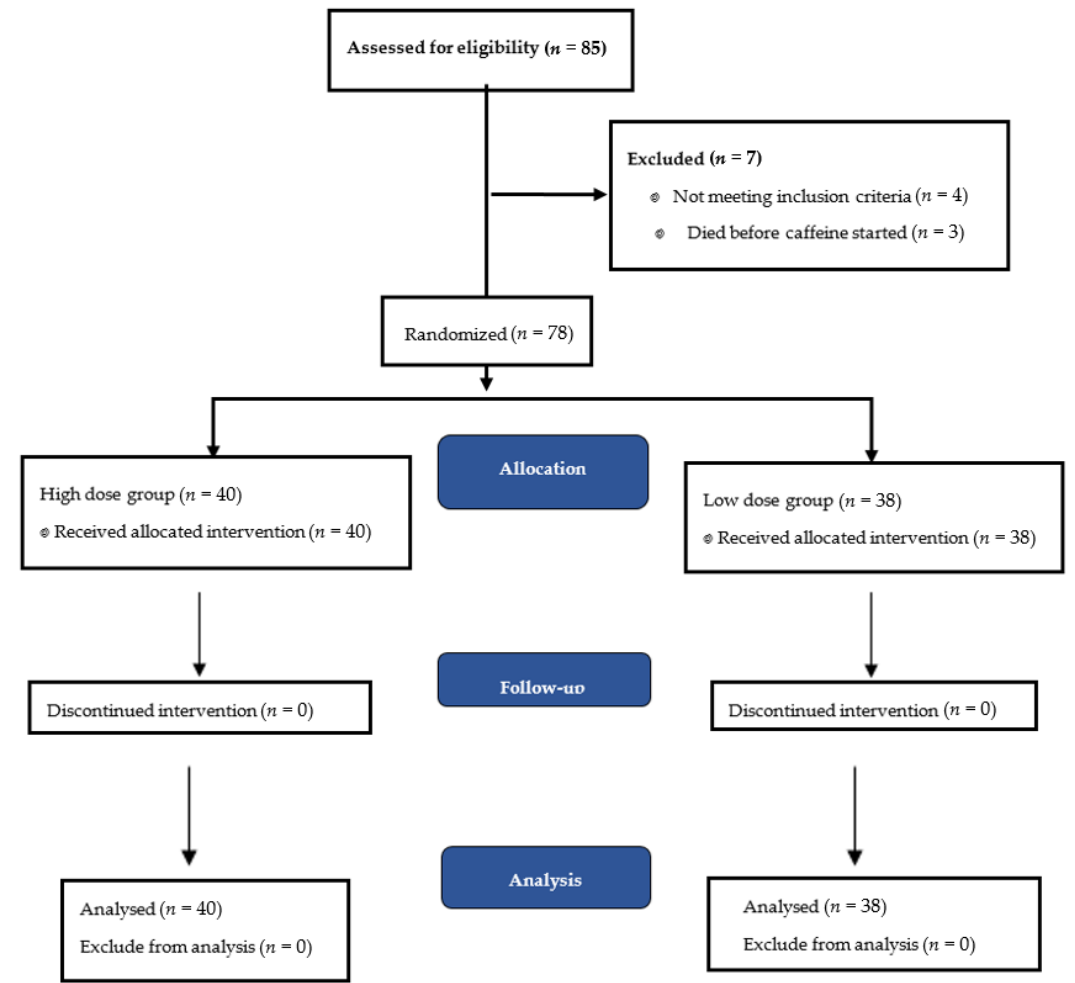
Figure 1. Study enrolment.